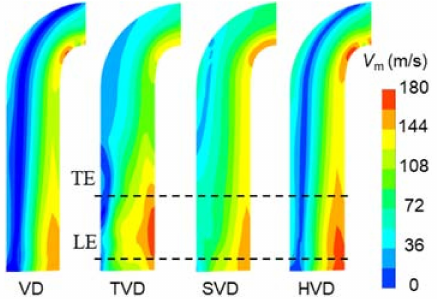
Figure 8. Distribution of meridional velocity at low mass flow rate operating point ( ϕ = 0.7 Q d